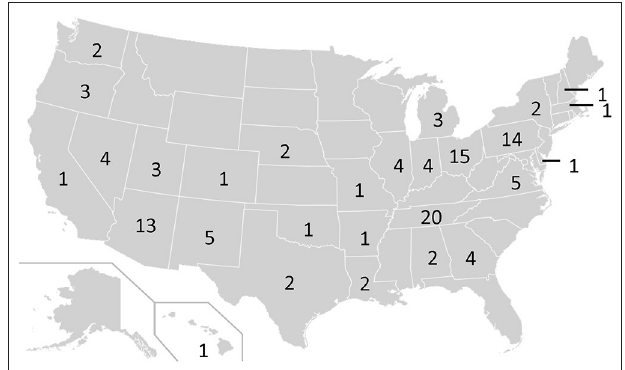
FIGURE 1 | Geographic distribution of number of survey respondents from juvenile justice systems ( N = 456; 15 participants did not note their geographic